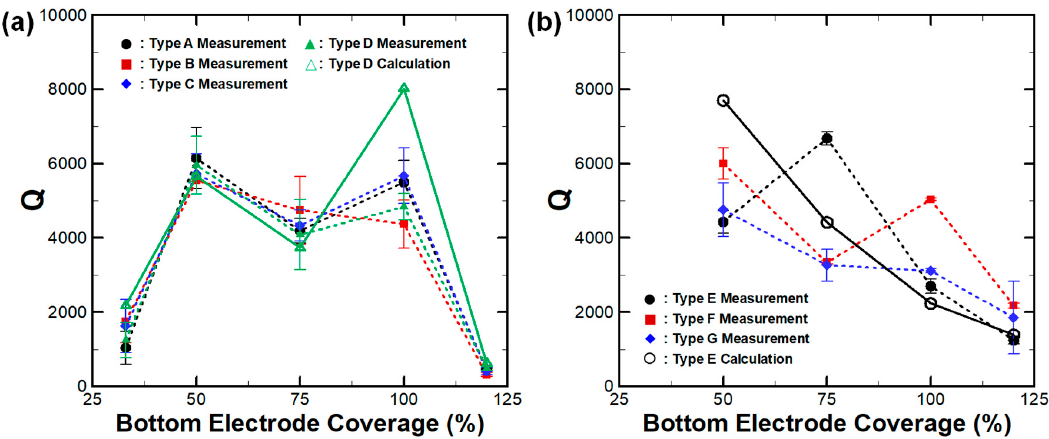
Figure 7. Measured (at 10 K) and predicted Q of ( a ) 230 MHz and ( b ) 1.1 GHz CMRs with varying bottom electrode coverages at 10 K. For all measured resonators, Q drastically improved by eliminating the thermoelastic damping (TED) effect. The prediction follows the general trends of the measurements.